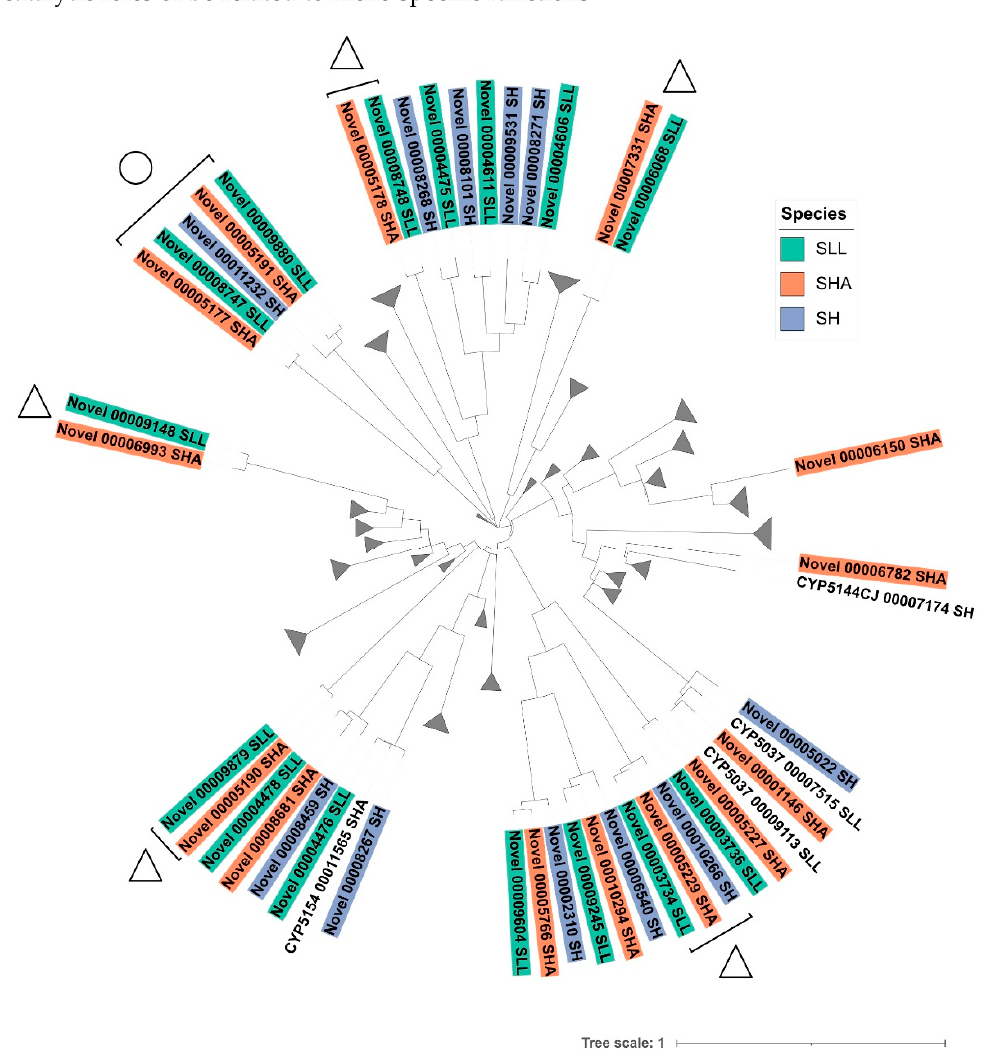
Figure 4. Phylogenetic analysis of the novel P450 sequences identified in S. lacrymans var. lacrymans (SLL), S. lacrymans var. shastensis (SHA) and S. himantioides (SH). A minimum evolution tree for all 398 sequences was generated using the close-neighbour-interchange algorithm in MEGA-X [20], and clades containing only named P450s were collapsed (represented by the grey triangles). Novel sequences were coloured by species. Evidence for gene orthologues is highlighted by the triangles and a grouping of novel sequences which does not share a branch with any named P450s is highlighted by the circle.